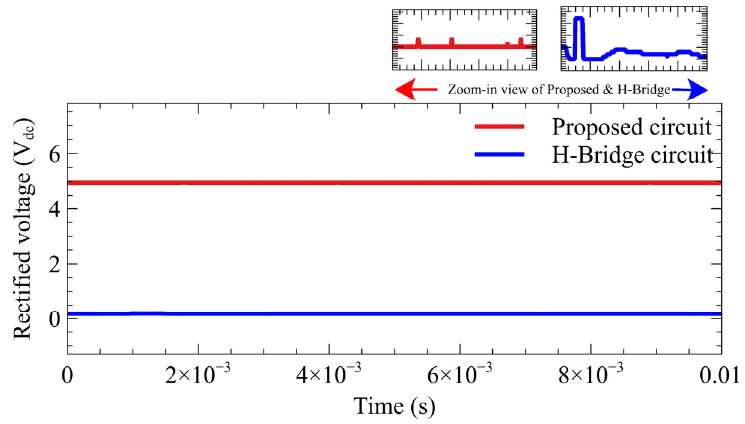
Figure 16. Rectified voltage of the proposed and H-Bridge circuit.